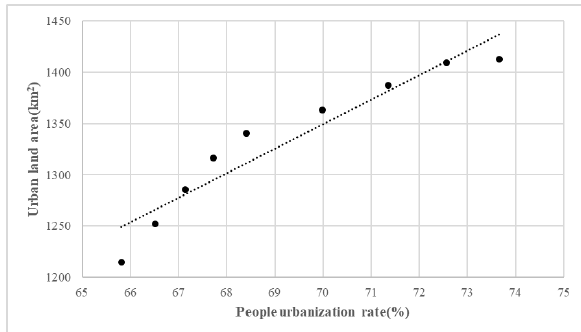
Figure 6 . Relationship between the urban land area and urbanization